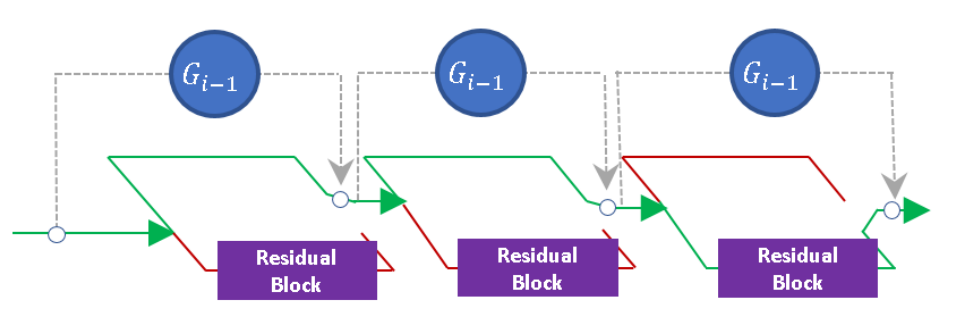
Figure 4. SkipNet Architecture that is embedded into DIP